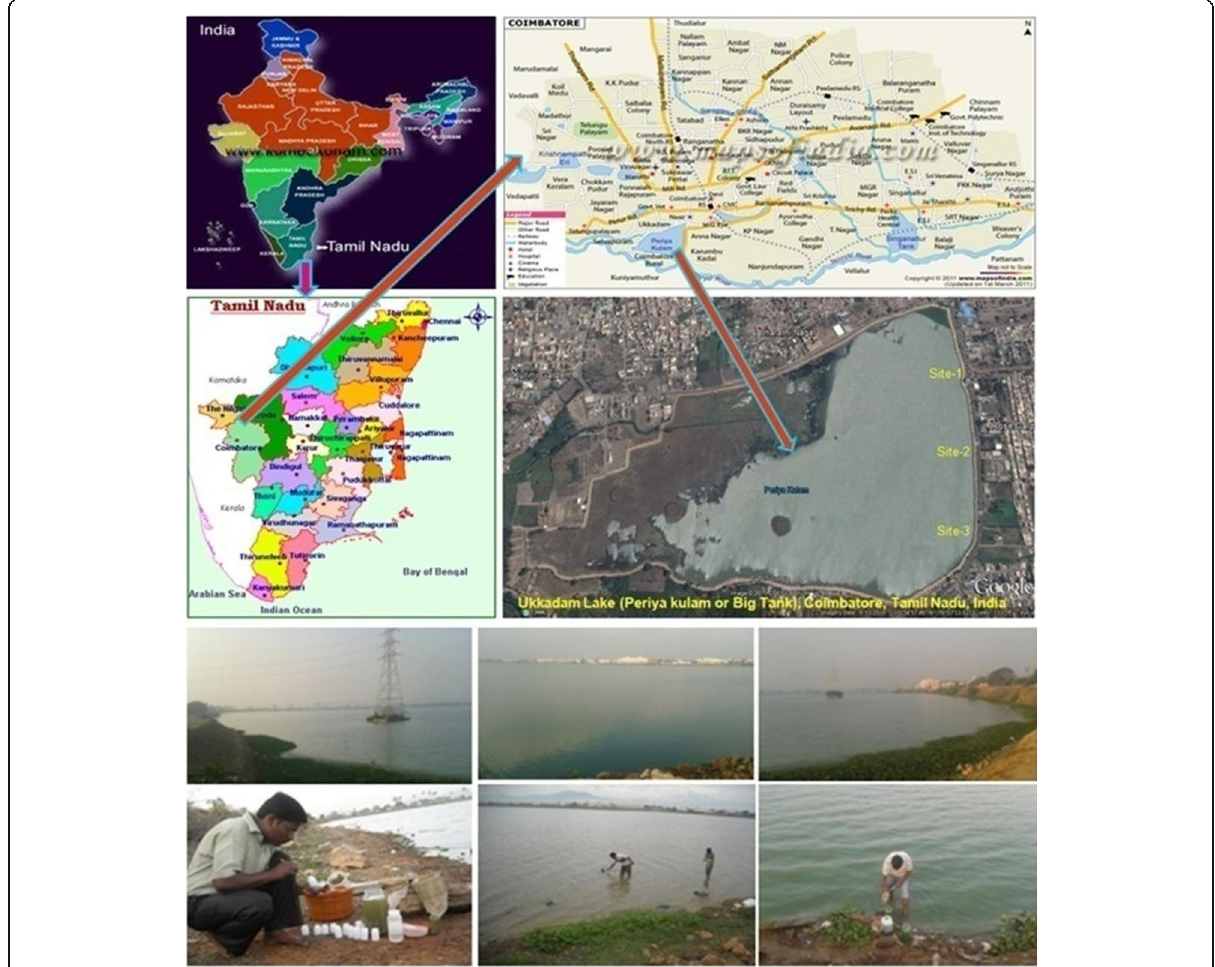
Fig. 1 Map showing sampling sites at the Ukkadam Lake, Coimbatore city, Tamil Nadu,